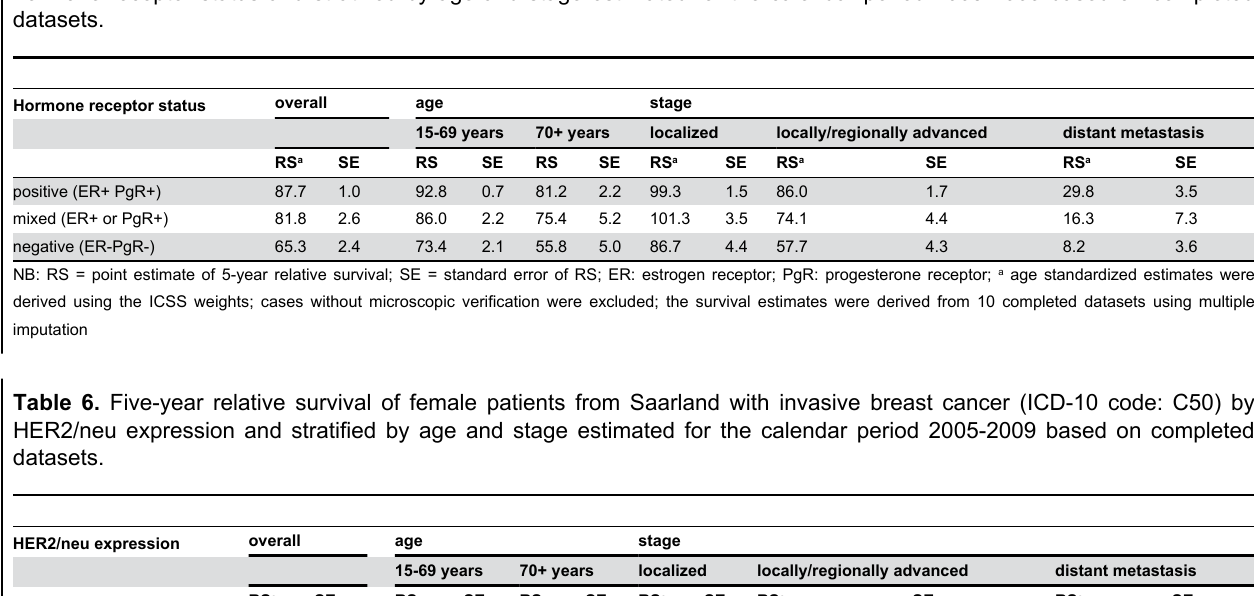
Grading overall